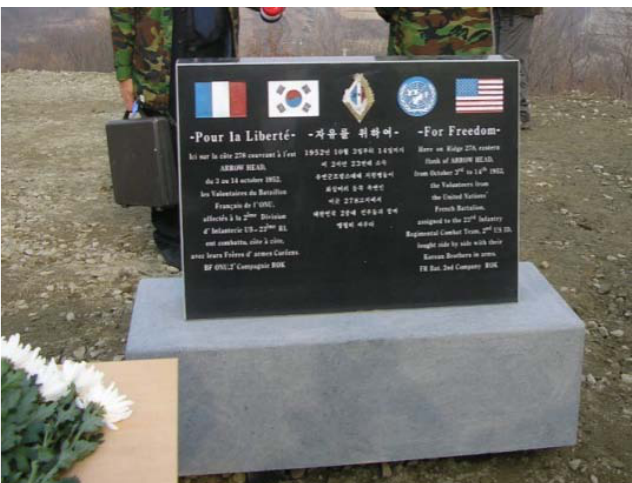
French, Korean and US flags are displayed alongside, with the UNO Symbol and French battalion insignia. © L. Quisefit. December